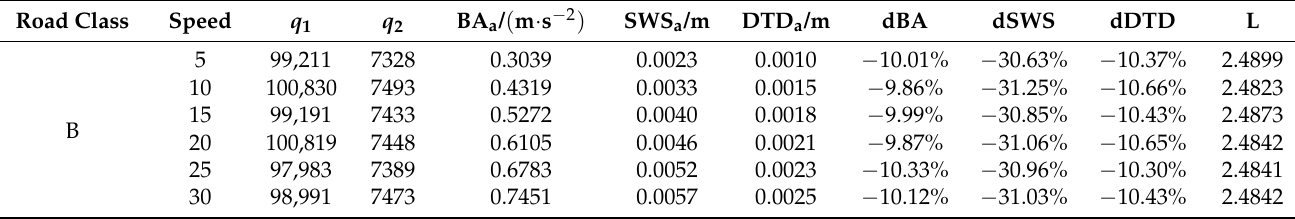
Table 6. Optimal solution and simulation results of safety mode under B-class